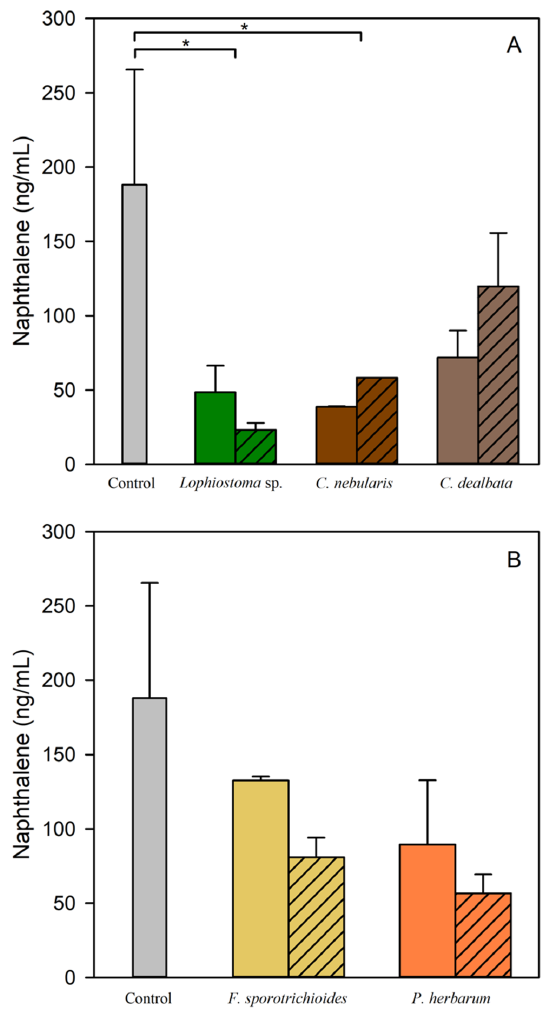
Figure 6. Gas chromatography mass spectrometry (GC-MS) measurement of naphthalene degra- dation by ( A ) the epiphytic fungus Lophiostoma sp. AT37 and the two strains used as positive con- trols for laccase and peroxidase production: C. nebularis and C. dealbata , growing on Kimura me- dium, and ( B ) the epiphytic fungi F. sporotrichioides AT11 and P. herbarum AT15, growing on Ingestad medium containing 2.5 g L − 1 fructose and 2.5 g L − 1 glucose, with shaded bars indicating the CuSO 4 -exposed condition. No-fungus media controls are indicated in gray. Statistically significant differences are indicated after performing one-way ANOVA by * ( p ≤